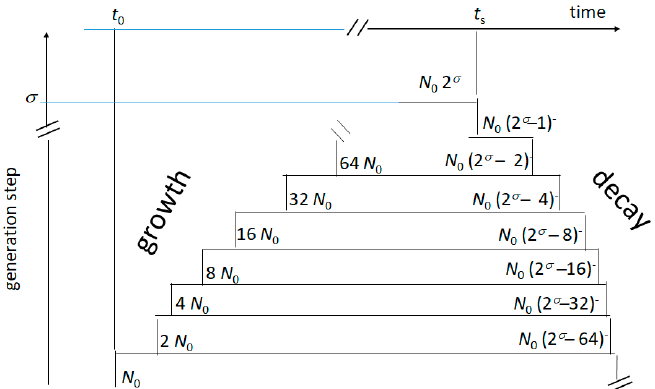
Figure 4. Sketched picture of the growth and decay of the ideal planktonic culture of the present model. At each step, 0 ≤ σ ≤ β (see text), the microbial population doubles (growth) or loses the oldest remaining generation (decay). The distance between steps depends on the variable duplication time (growth, Equation (1)), or shrinks (decay, Equation (4)) as the medium conditions worsen.